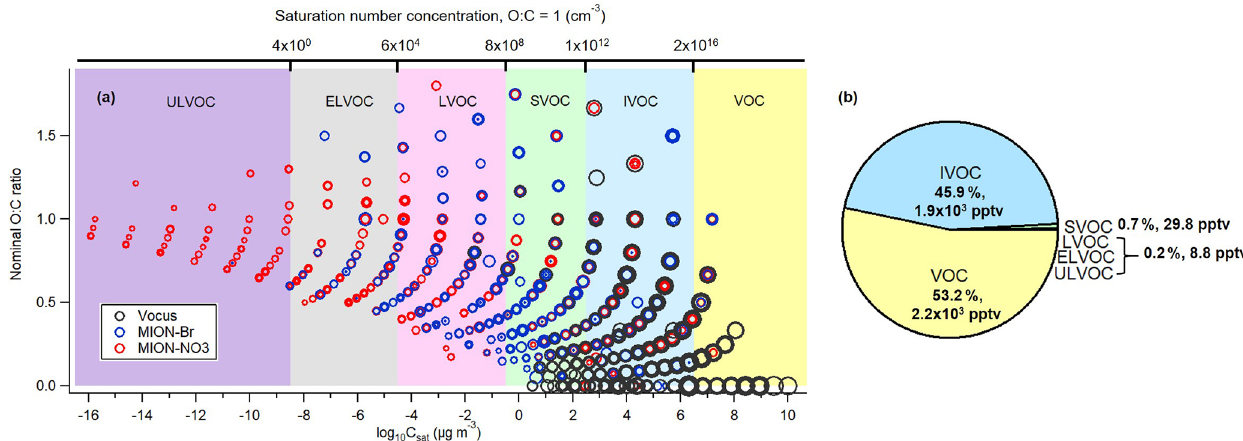
Figure 7. (a) Combined two-dimensional volatility distribution for all measured organic compounds (with the approach described in Sect. 2.2.1) parameterized with the modified Li et al. (2016) approach (Daumit et al., 2013; Isaacman-VanWertz and Aumont, 2021). Markers were sized by the logarithm of their corresponding concentrations, and marker color represents that either the compound was only measured by that instrument or the maximum concentration of the compound observed in common was detected by that instrument; (b) resulting pie chart for the contributions of VOC, IVOC, SVOC, LVOC, ELVOC, and ULVOC